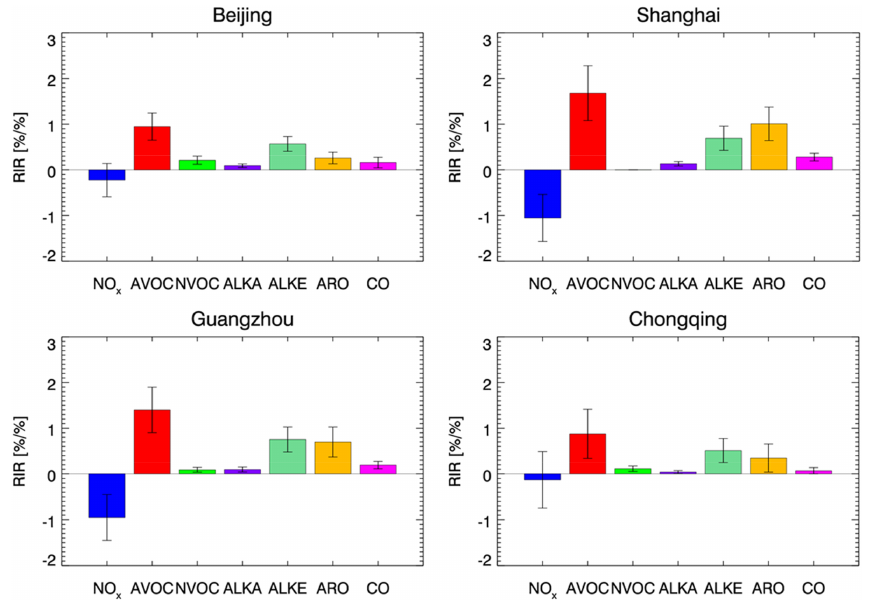
Figure 10. Relative incremental reactivity analysis for NO x , AVOCs (anthropogenic volatile organic compounds), CO, and NVOCs (natural volatile organic compounds; in this study only isoprene was considered) at four sites.